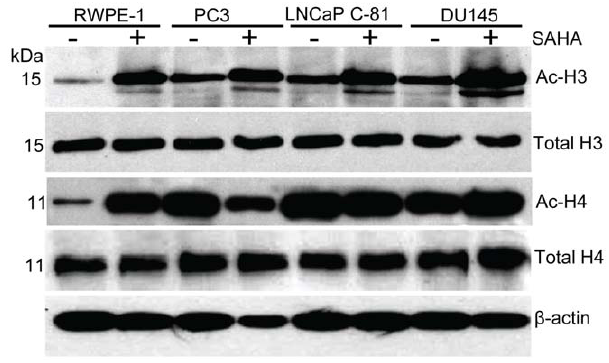
Figure 9. SAHA treatment of RWPE-1 cells increases acetylated H3 and H4 histones. Cell lysates were prepared from RWPE-1, PC3, LNCaP C-81 and DU145 cells treated with PBS or 5 m M SAHA for 72 h. Proteins (100 m g) were separated on 15% SDS-PAGE and blotted onto a PVDF membrane. The acetylated histone-3 and histone-4 proteins were detected with H3 and H4-specific antibodies along with total histone protein antibodies. The b -actin from same samples was used as a protein loading